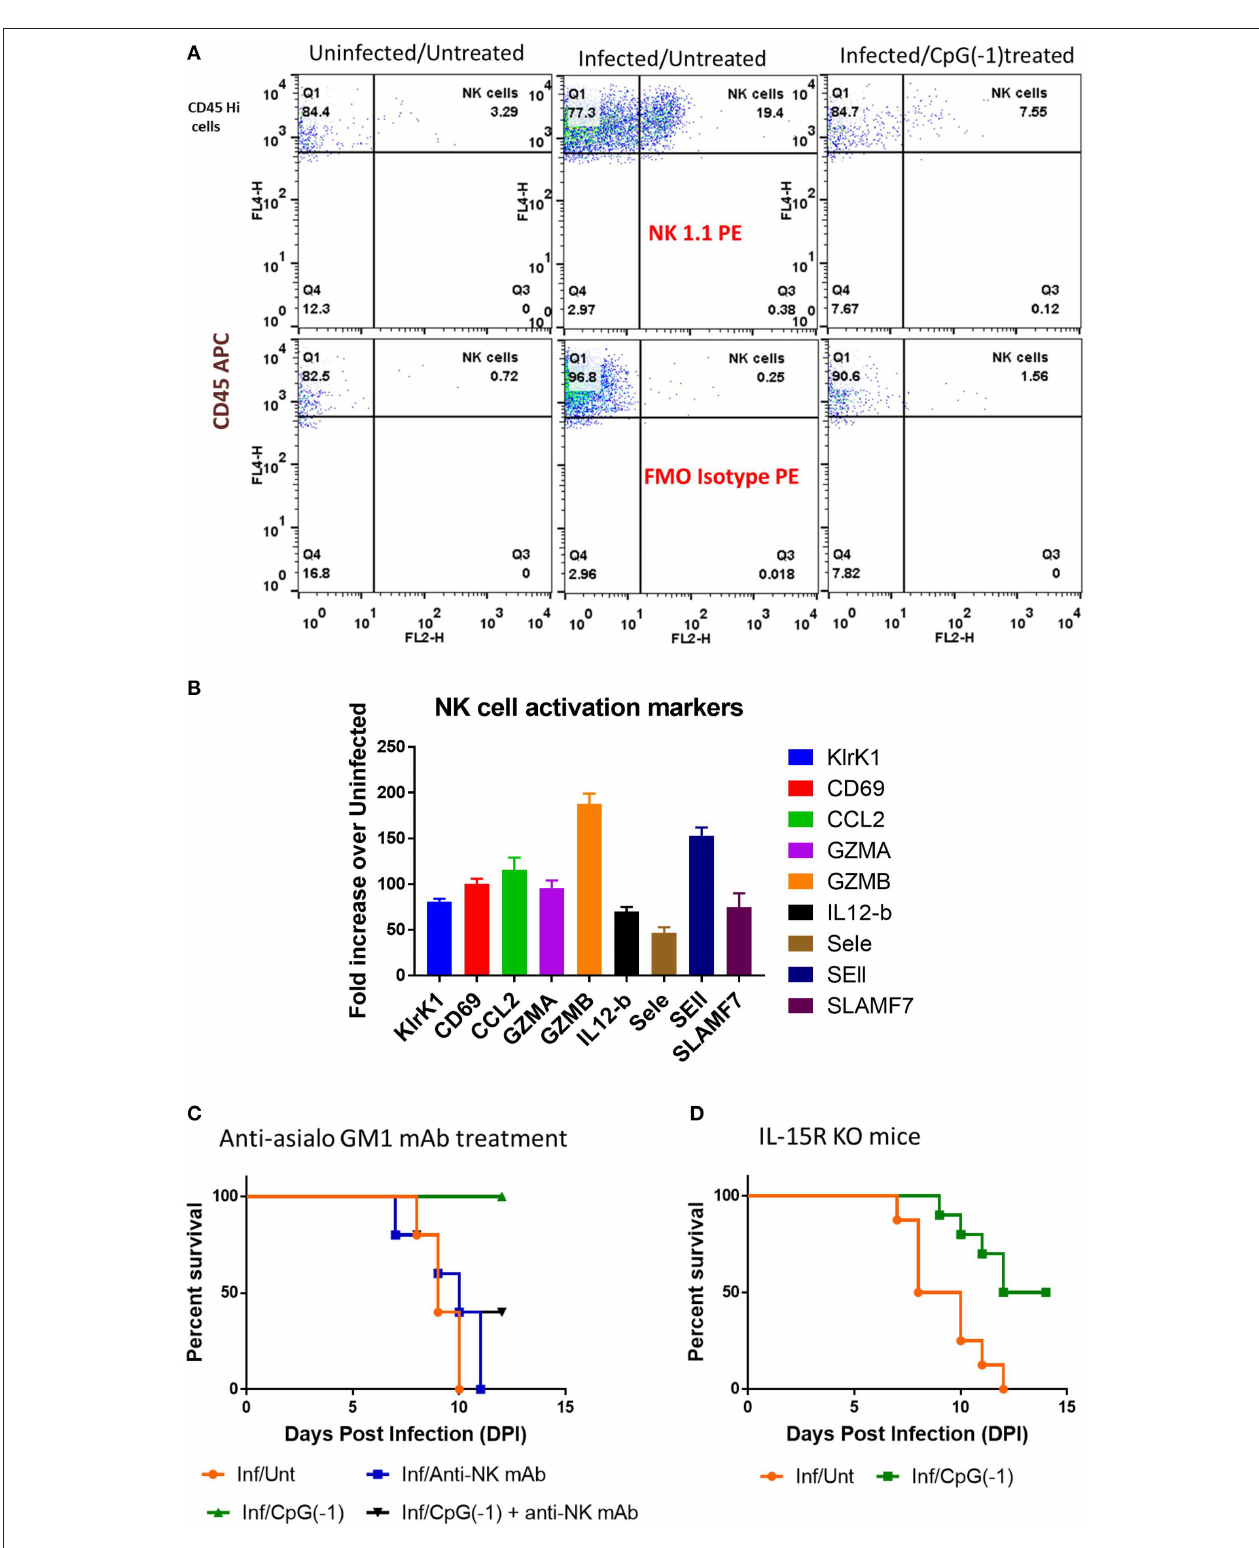
FIGURE 8 | Role of NK cells in CpG ODN mediated protection from lethal SINV infection. (A) NK cell infiltration in brains of B6-WT mice uninfected, infected with SINV and treated with CpG ODN prior to infection with SINV as described above. Infiltrating NK cells were stained using CD45 and NK1.1. (B) Expression of NK cell related genes in the brains of infected mice (C&D) Survival of mice defective in NK cells pre-treated and infected as above. (C) SINV B6-WT mice treated with anti-asialo GM1 (50 uL IP) P2 and P5. (D) B6-129 IL15RA KO mice.